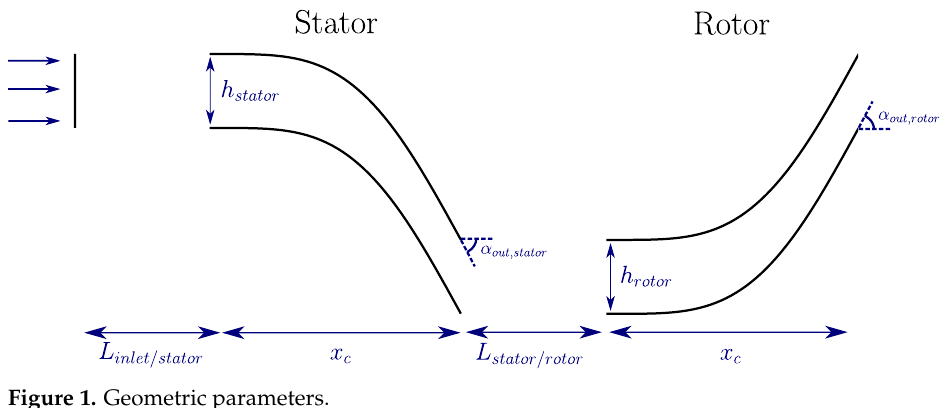
Figure 1. Geometric